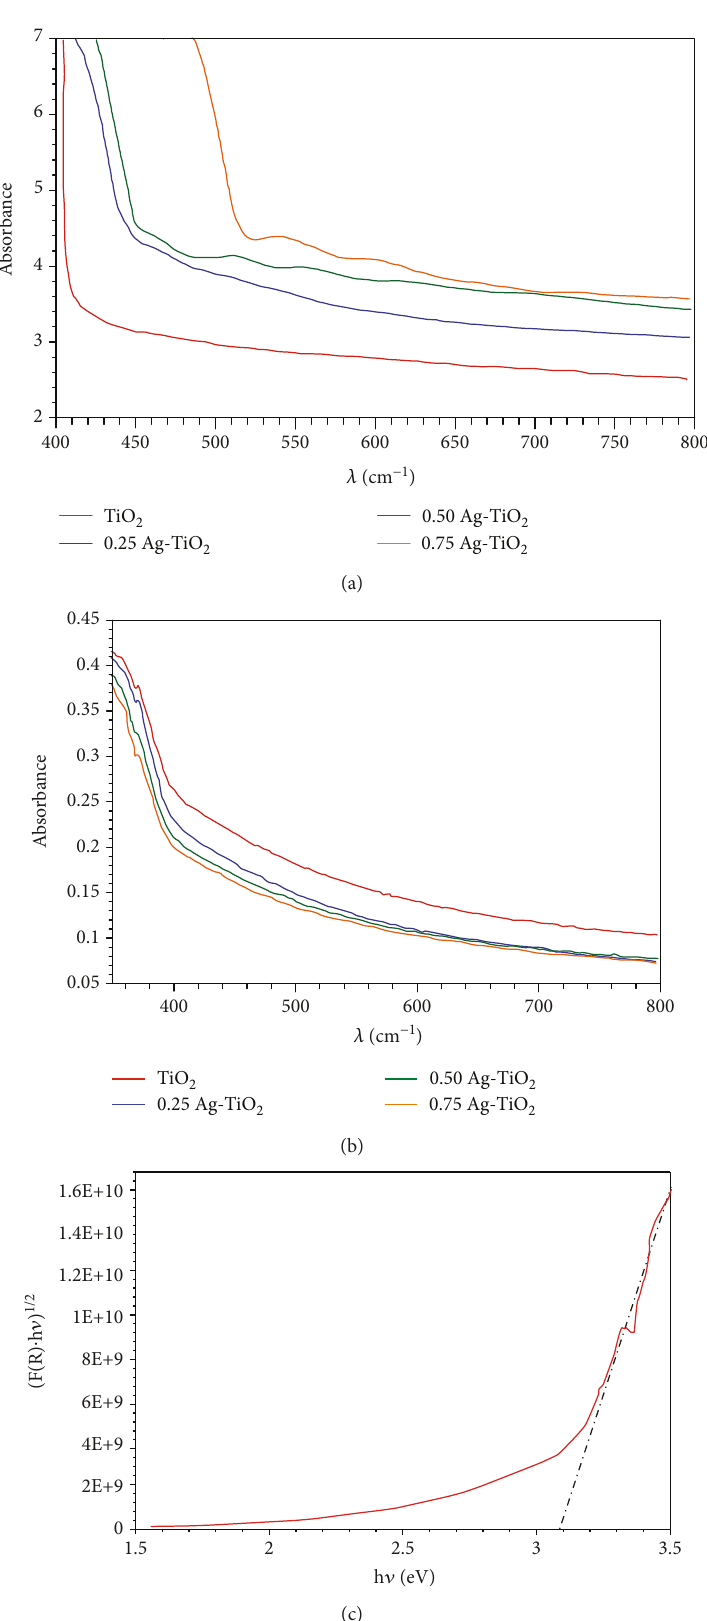
Figure 4: UV-vis absorption spectra of (a) the as-prepared nano-Ag-TiO Kubelka-Munk plot for TiO